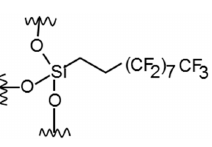
Figure 3. Single component system with perfluorodecyl (PFD), represents the inorganic network.